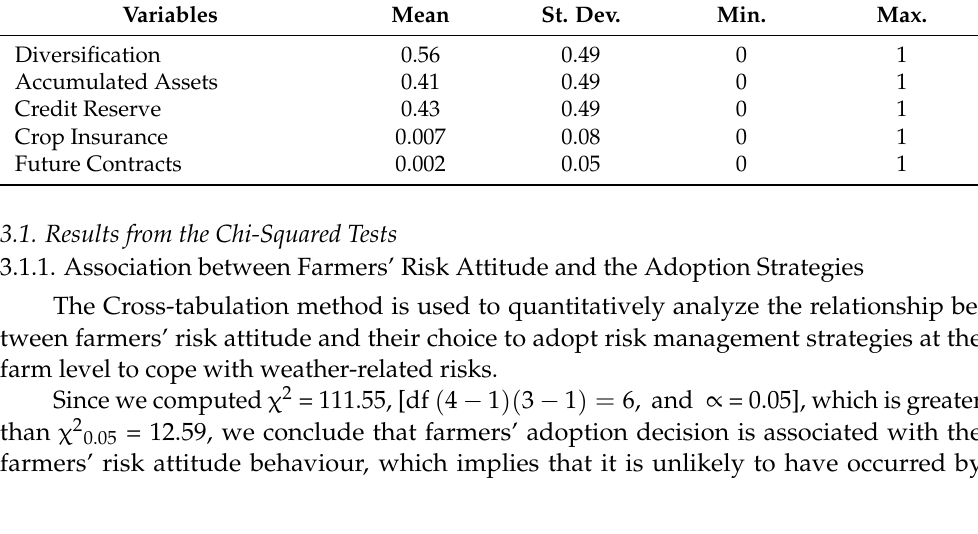
Table 7. Distribution of Risk Management Strategies Adopted by Sampled Respondents.